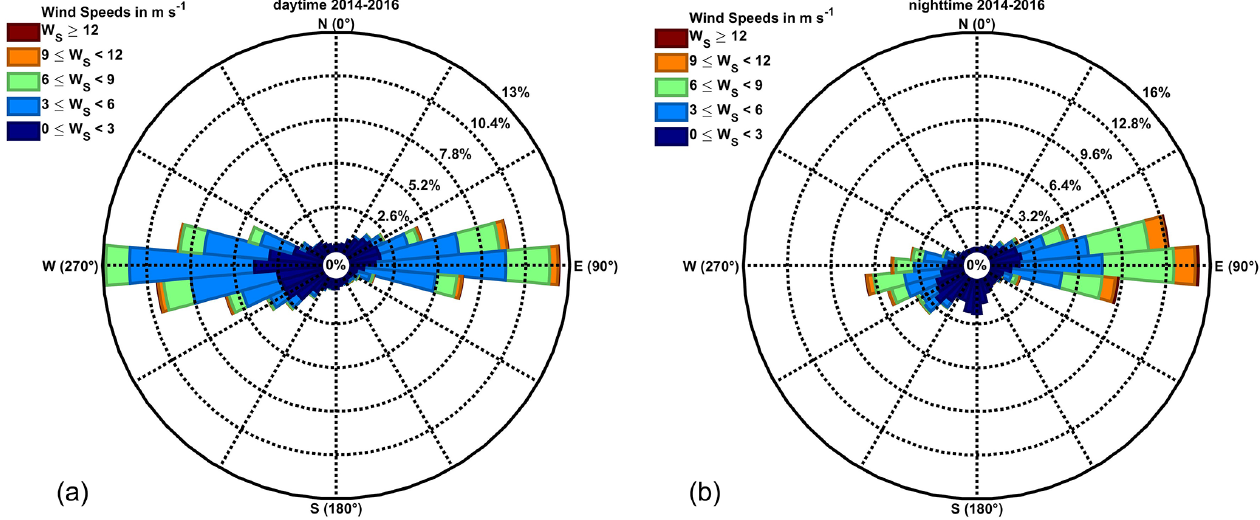
Figure 1. The wind rose for the SE-Sto tower for years 2014–2016 for the daytime (a) and nighttime (b) .